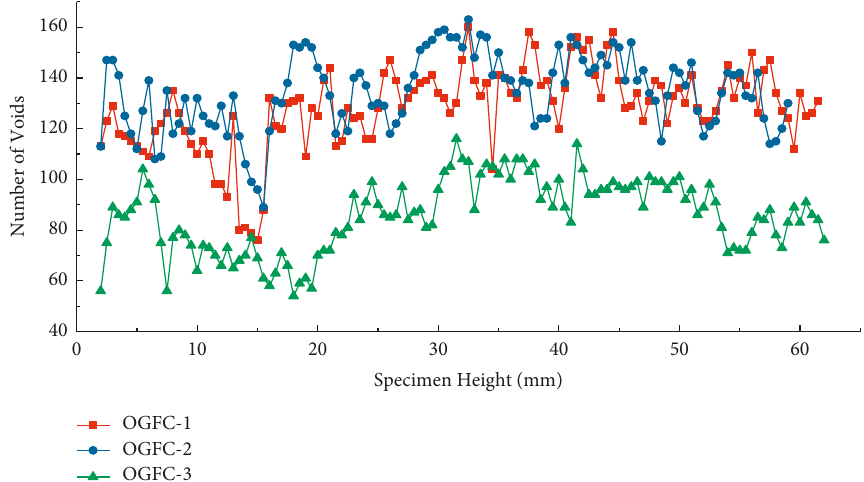
Figure 3: Distribution of the number of voids along the height of the specimen.